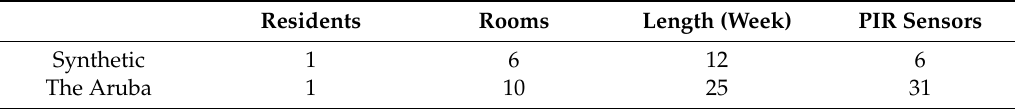
Table 4. Datasets Summary.